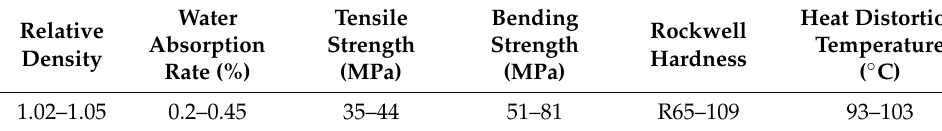
Table 2. Properties of PVDF materials. Table 1. Properties of ABS materials.